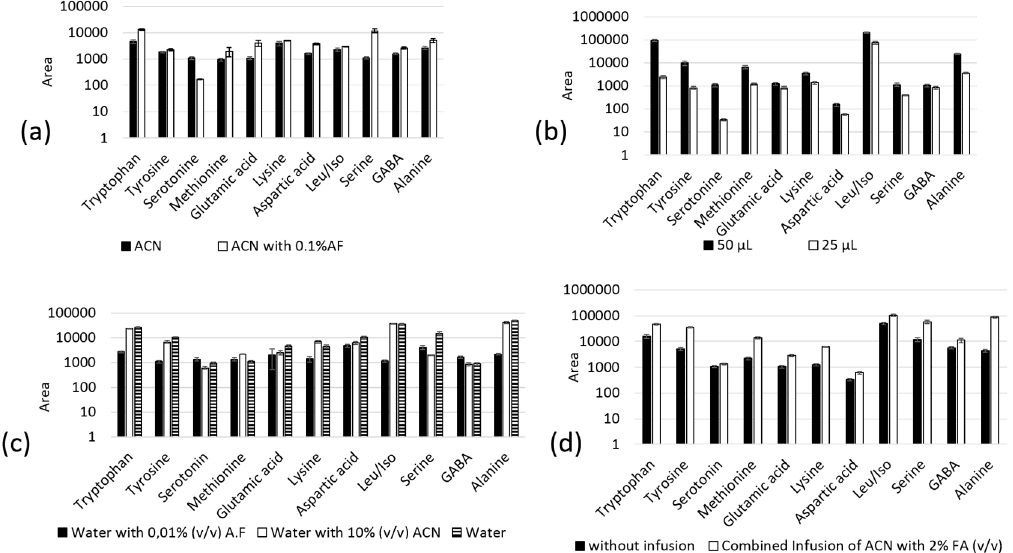
Figure 4. Effect of ( a ) sample solvent (acetonitrile and acetonitrile with 0.1% ( v / v ) formic acid on the pre-concentration step; ( b ) sample solvent volume (acetonitrile with 0.1% formic acid); ( c ) mobile phase for the elution step; and ( d ) post capillary infusion of acetonitrile with 2% formic acid (FA) on the performance of the in-tube SPME–MS/MS procedure.